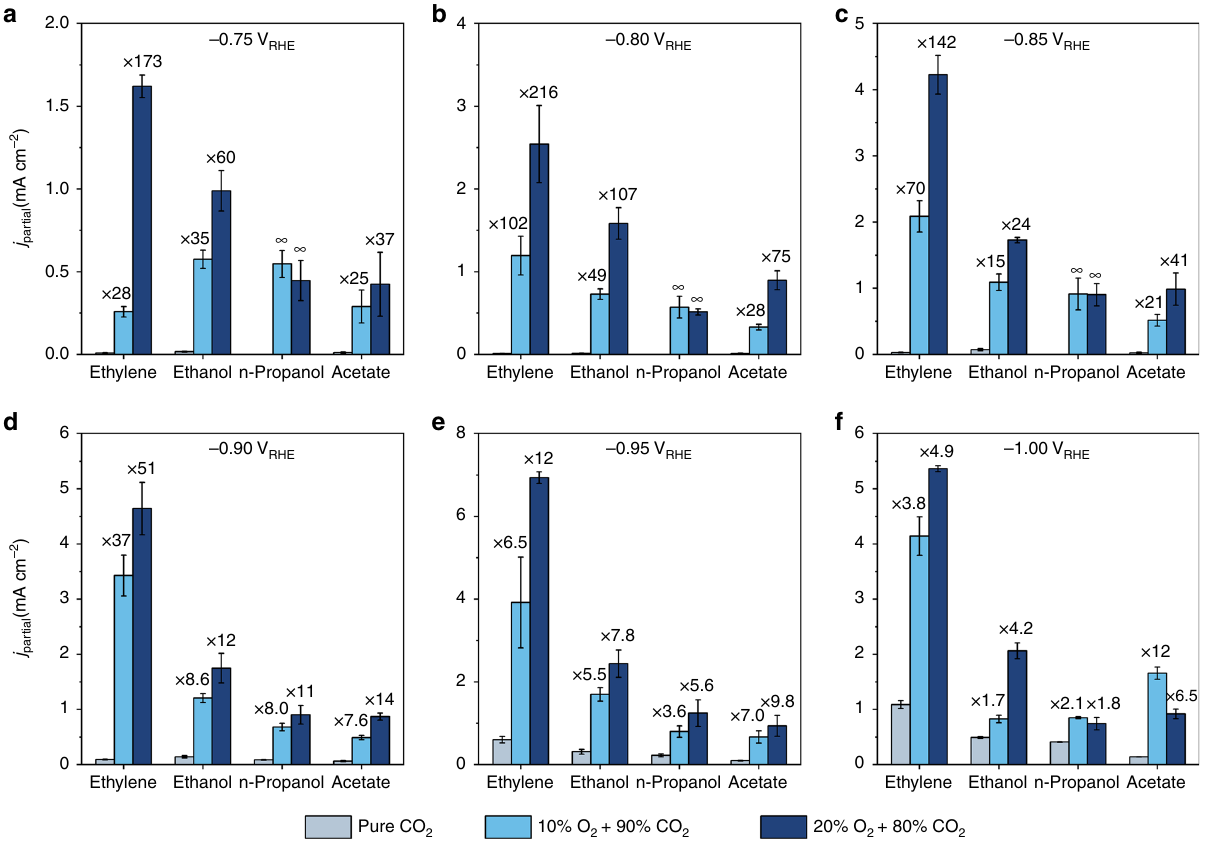
Fig. 1 Comparison of C 2 + product formations. The partial current densities of C 2 + products measured at 100% CO 2 , 10% O 2 + 90% CO 2 , and 20% O 2 + 80% CO 2 are compared at different potentials of a − 0.75 V RHE , b − 0.80 V RHE , c − 0.85 V RHE , d − 0.90 V RHE , e − 0.95 V RHE , and f − 1.0 V RHE . The numbers stand for the enhancement relative to the rates at pure CO 2 . The error bars represent the standard deviation from at least three independent